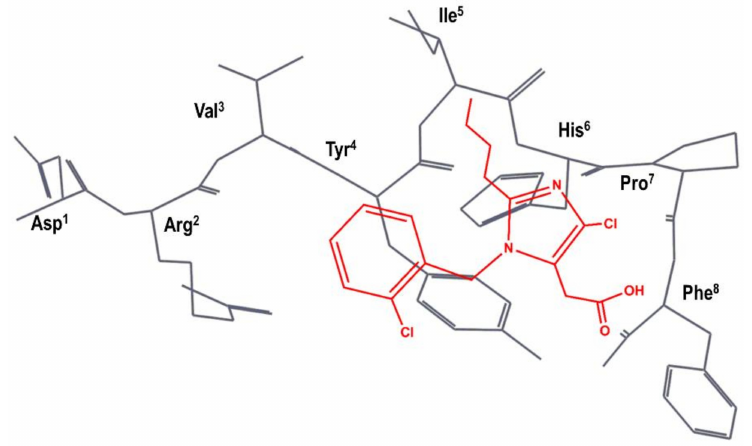
Figure 4. SKB hypothesis of the superimposition of S-8307 (in red) to the AII bioactive conformation (in black), as described in reference [50]. The Figure has been re-constructed using the bioactive conformation of AII taken from pdb id: